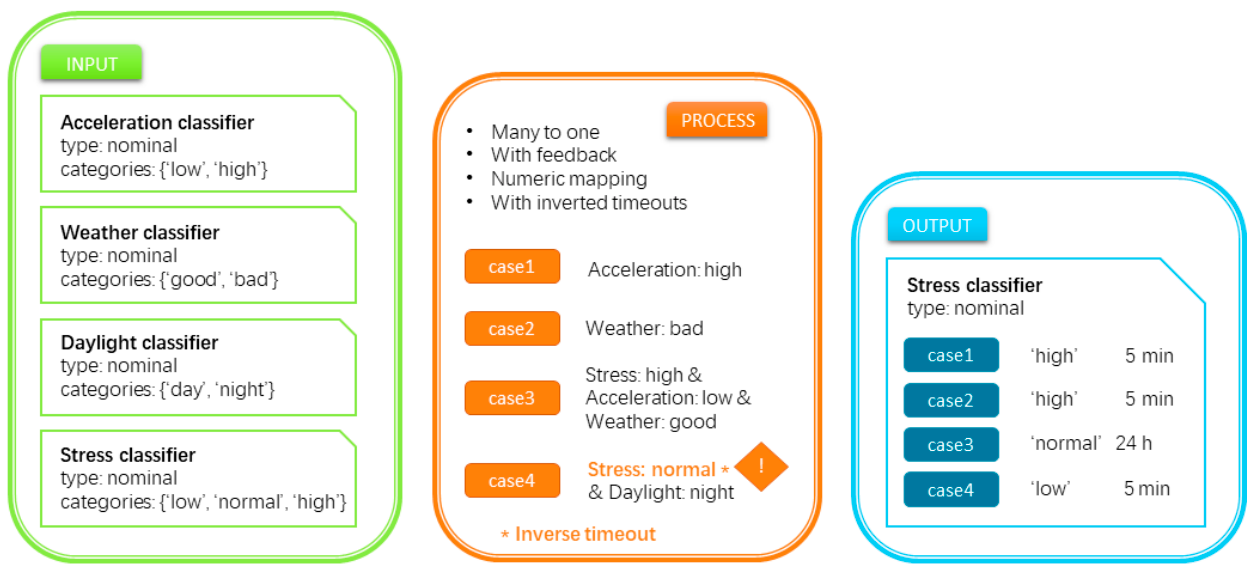
Figure 5. A complex node that processes nominal data and functions as a timed-state machine by merging input data from three other nodes with its previous output and taking into consideration time-related information, including inverting the timeout period.